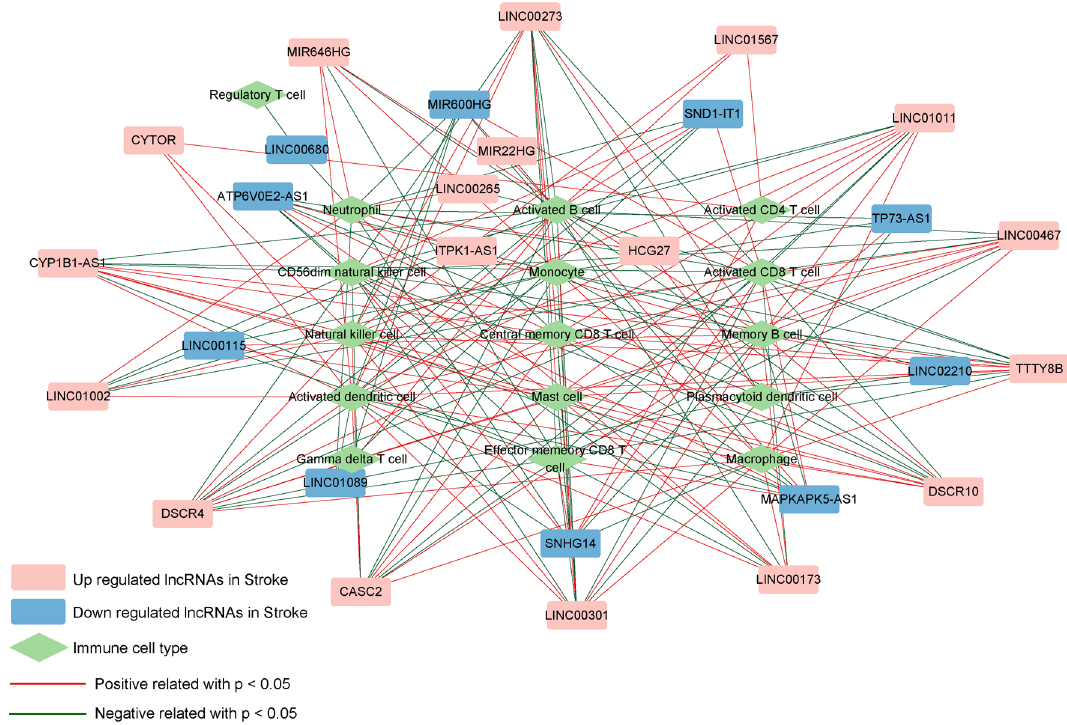
Figure 3. The lncRNA-immune cell correlation network consisting of TLR signaling pathway related lncRNAs and immune cell types with significant differences in